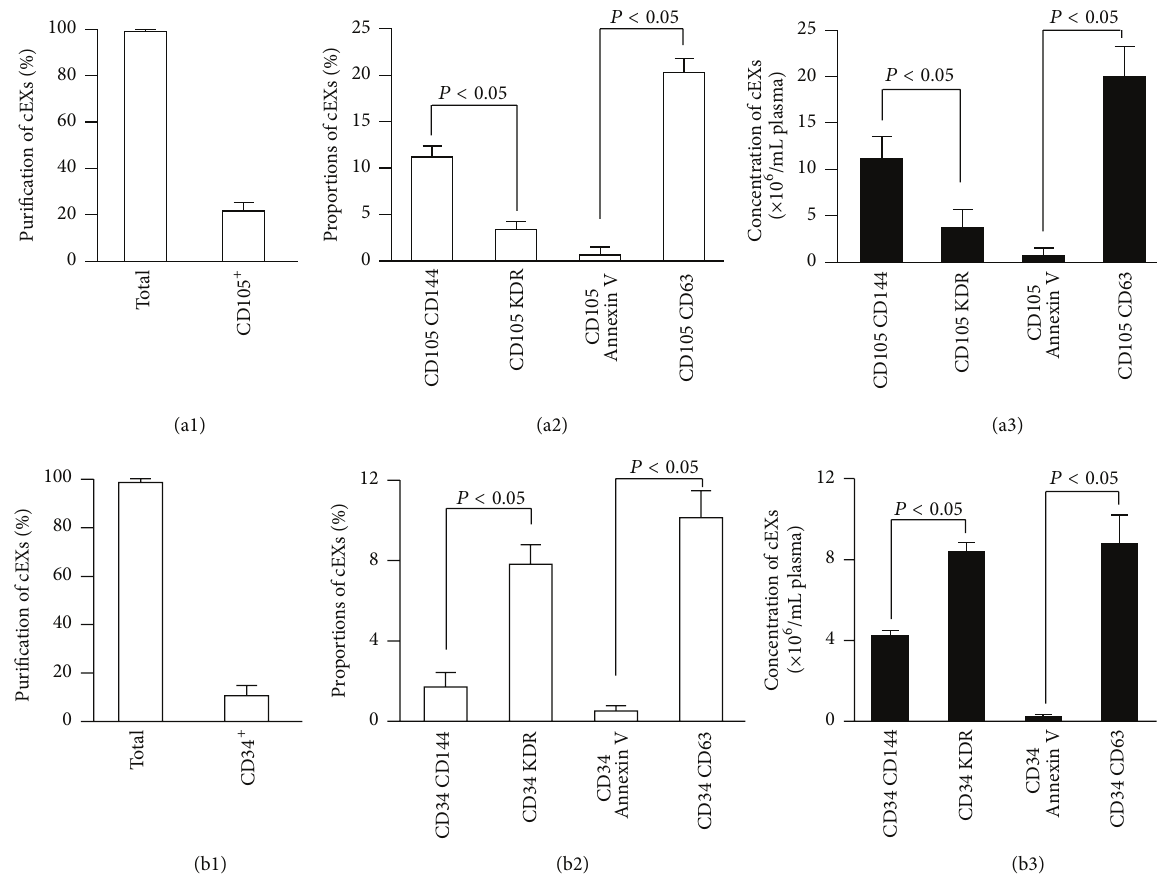
Figure 6: Identification of cEC-EXs and cEPC-EXs from human plasma by using anti-CD105- or anti-CD34-conjugated microbeads and Q-dots combined with fluorescence NTA. ((a1) and (b1)) The proportions of CD105 + cEXs and CD34 + cEXs in plasma that were isolated by anti-CD105- or anti-CD34-conjugated microbeads. ((a2) and (b2)) The proportion of CD105 + cEXs or CD34 + cEXs colabeled with CD144-, or KDR-, or Annexin V-, or CD63-conjugated Q-dots in total cEXs. ((a3) and (b3)) The absolute number of CD105 + cEXs and CD34 + cEXs that were labeled with CD144, or KDR, or Annexin V, or CD63 per mL day 1 ischemic stroke patient plasma. 𝑁 = 8 /group.